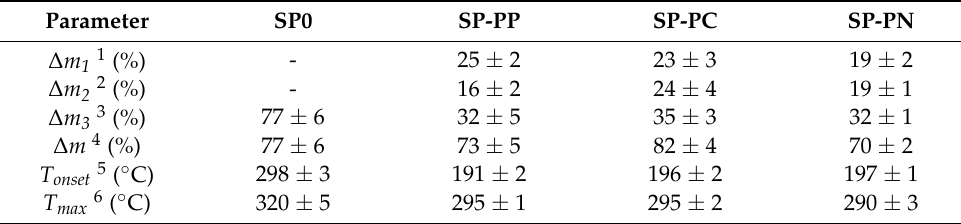
Figure 4. DTA-TG curve ( A ) and TG-DTG curve ( B ) for SP-PN propellant. Table 5. Thermal properties of propellants.